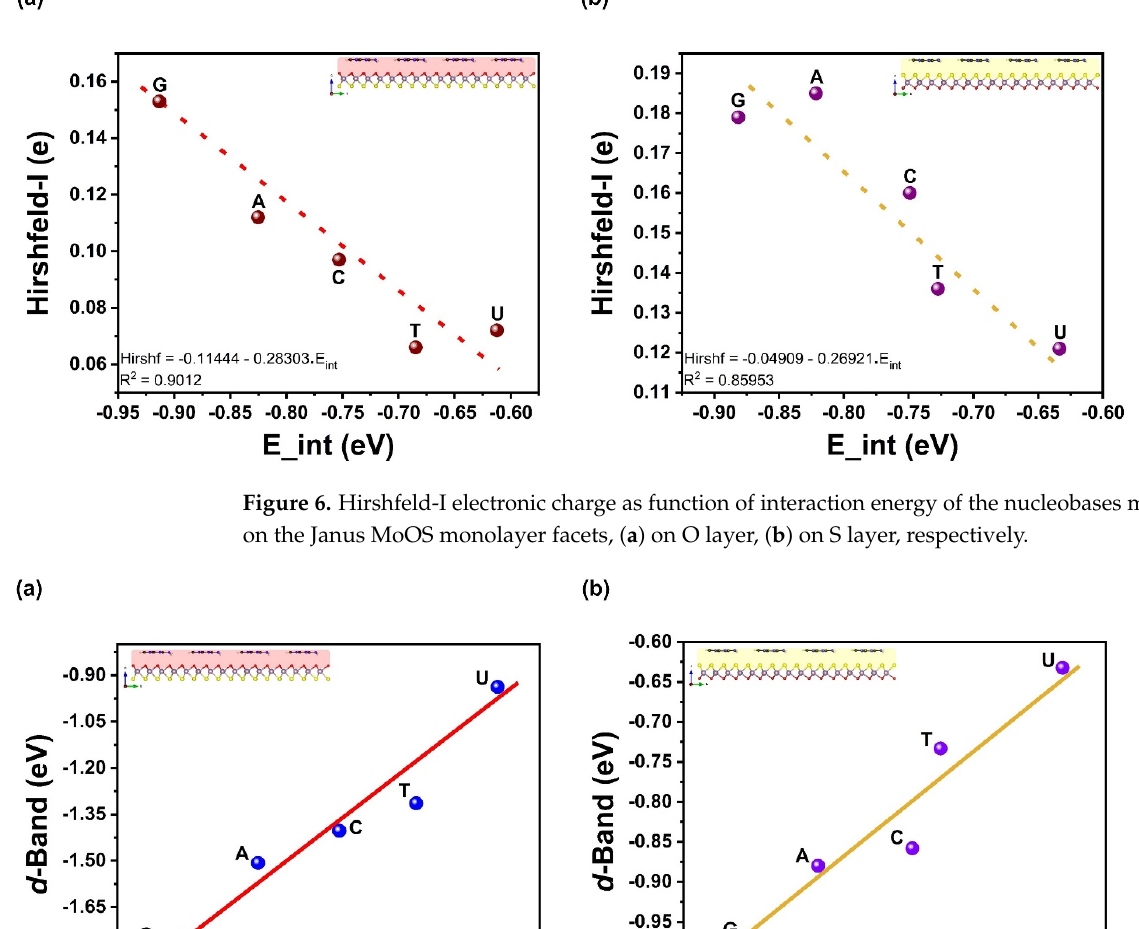
Figure 5. The van der Waals energy as function of density affinity of the nucleobases molecules on the Janus MoOS monolayer facets, ( a ) on O layer, ( b ) on S layer, respectively.